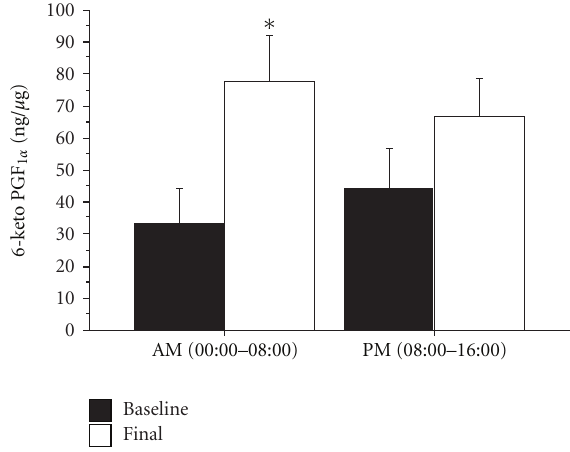
Figure 1: Urinary 6-keto PGF 1 α levels increased from 33 . 5 ± 11ng/ug to 77 . 8 ± 14 . 1 ng/ug during the AM period after the bout of exercise when compared to baseline. Levels returned to near baseline during the PM collection following the exercise bout, ∗ P < .